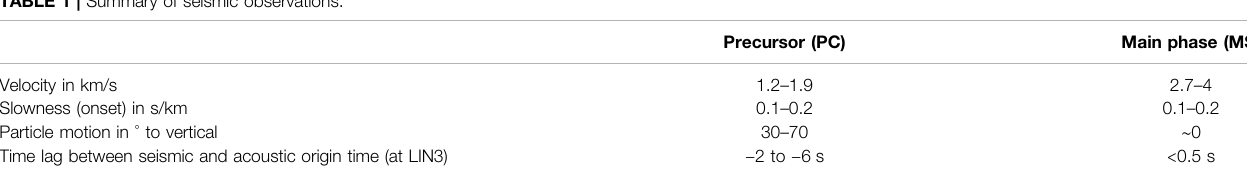
TABLE 1 | Summary of seismic